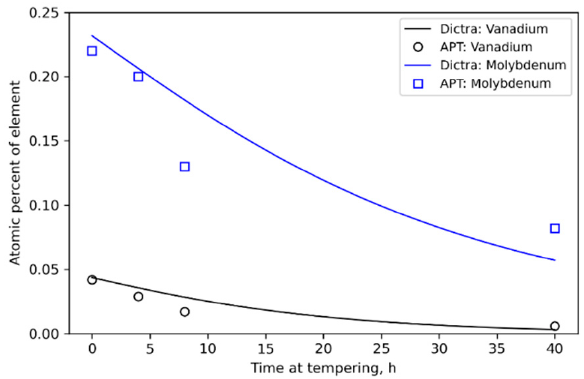
Figure 11. Concentration (at%) of Mo and V according to APT measurements of matrix composition and Dictra simulations of total content in the matrix at isothermal aging at 600 °C.